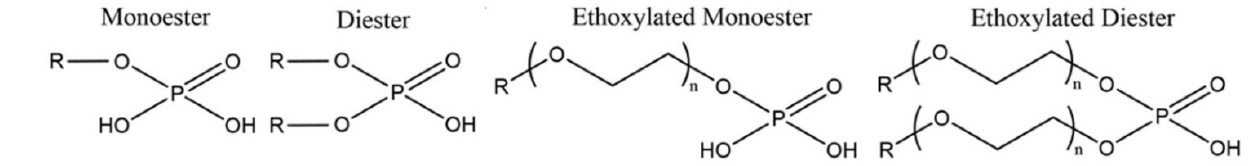
Figure 7. The general formulas for non-ethoxylated and ethoxylated phosphoric acid esters.